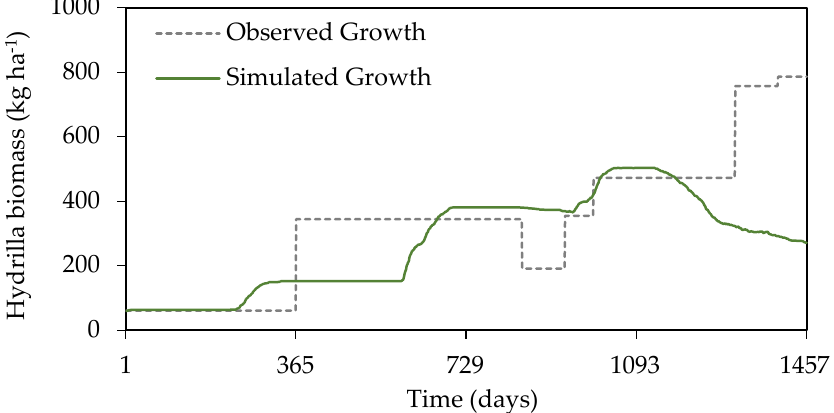
Figure 5. Comparison of simulated biomass dynamics of Hydrilla to those observed in Lake Conroe from 2004 to 2007 [46].